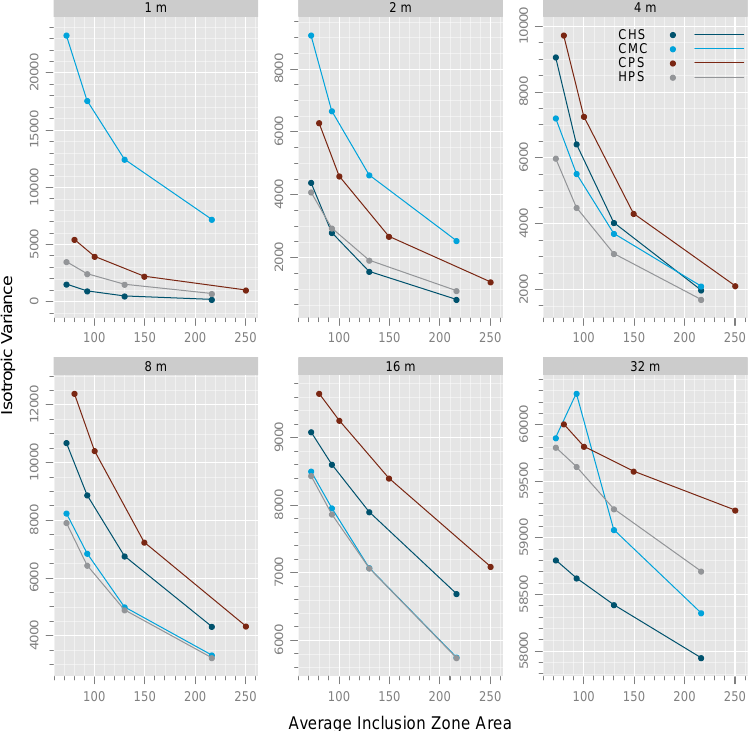
Figure 4. MODWT Smith plots of the simulations in Table 1 where the individual panels show the variance relations by wavelet decomposition distance τ (cid:48) variances, while only the coarsest scale at 32 m contains the scaling (smooth) variance component as